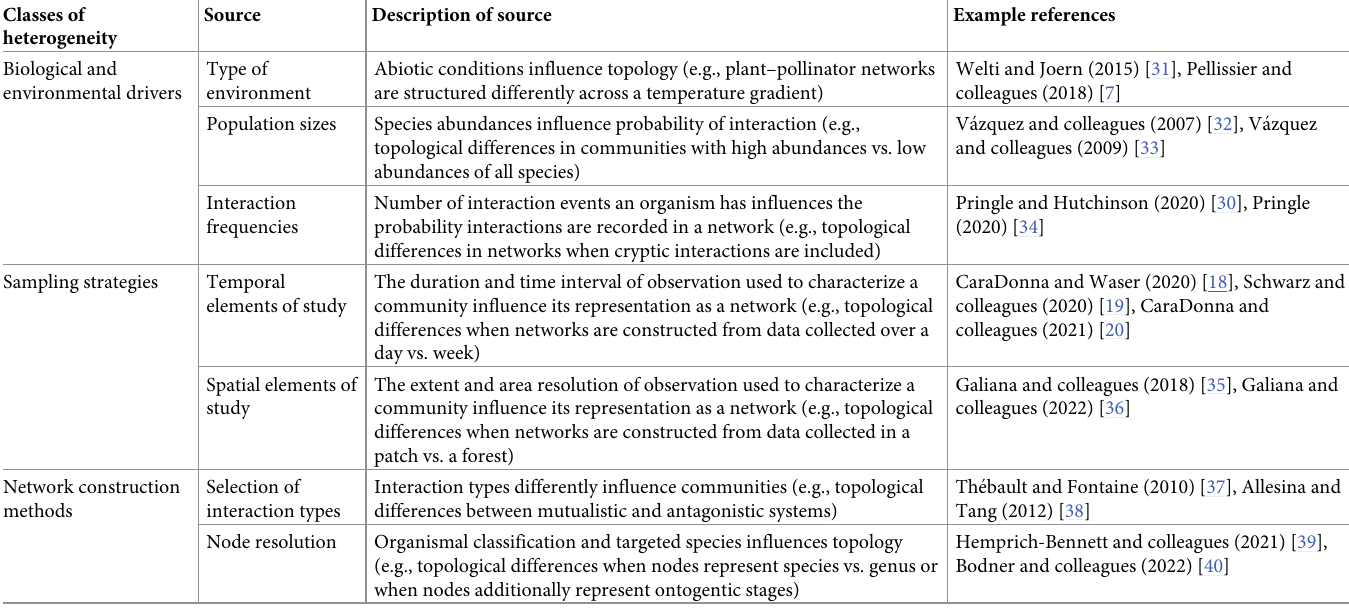
Table 1. Classes of topological heterogeneity that influence species interaction networks, some sources of this topological heterogeneity, a description of the source, and